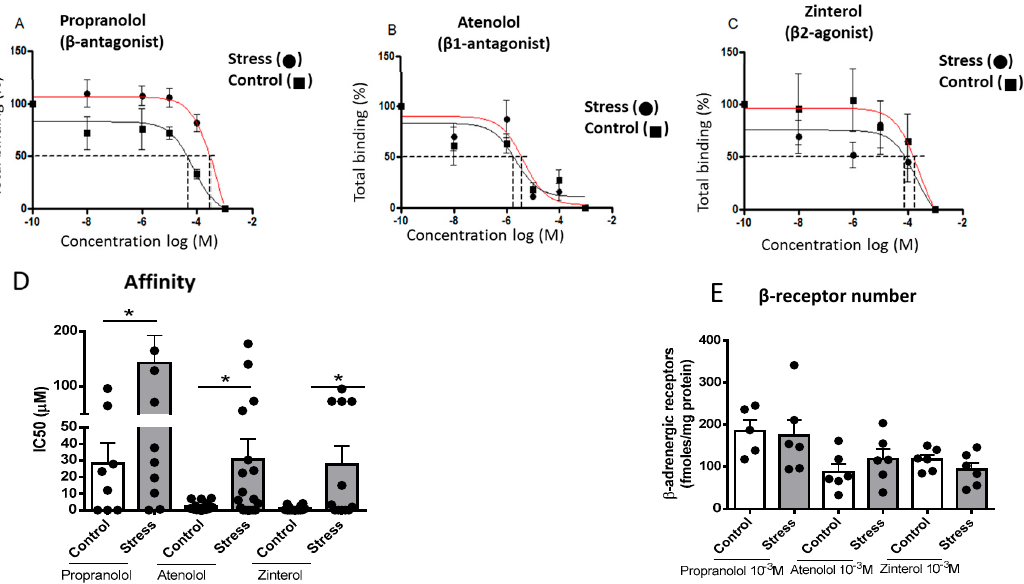
Figure 4. Effect of gestational stress on the displacement of 3 H-DHA and in the affinity of β receptors from a membrane fraction of heart homogenate from male progeny at 60 days old. In ( A – C ), the displacement of the binding of dihydroalprenolol by increasing doses of propranolol, atenolol, and zinterol, respectively, is shown. ( D , E ) correspond to the affinity of each of the β ligands and the number of binding sites for each drug, respectively. The results correspond to the mean ± SEM of 6 individual experiments for control and stressed rats. * p < 0.05 stress vs. control.